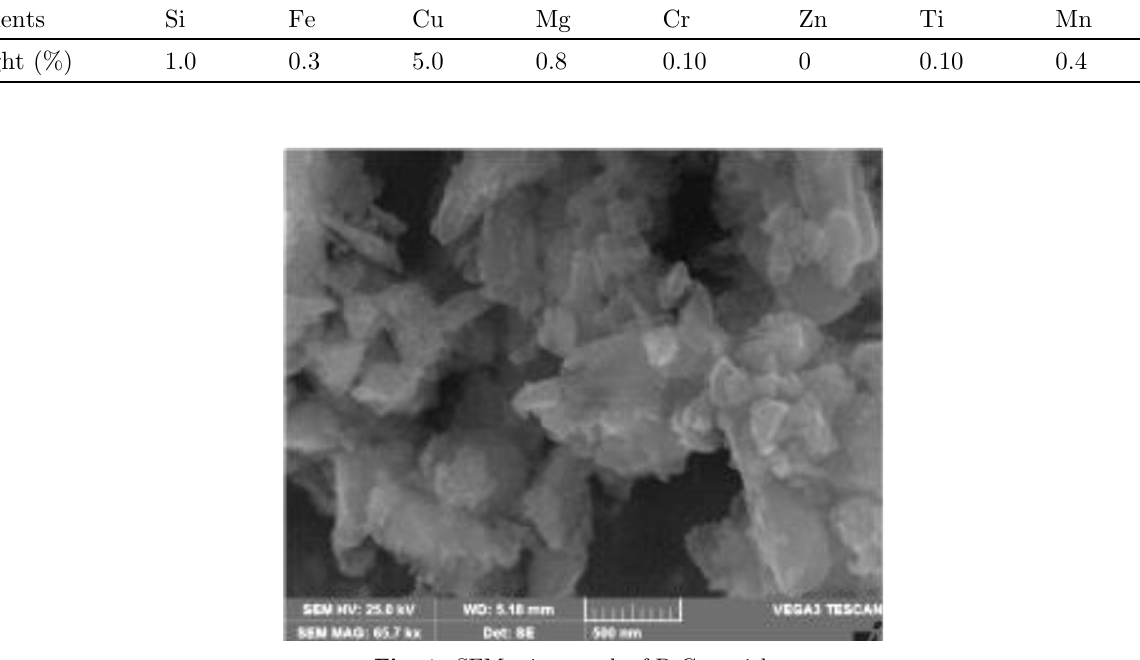
Fig. 1. SEM micrograph of B 4 C